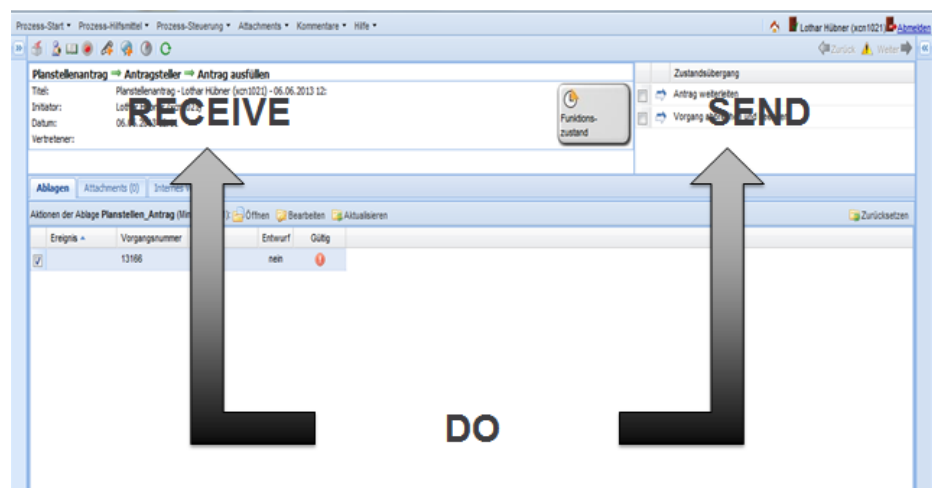
Figure 10. Executing the behavior of a subject using Metasonic Flow ®